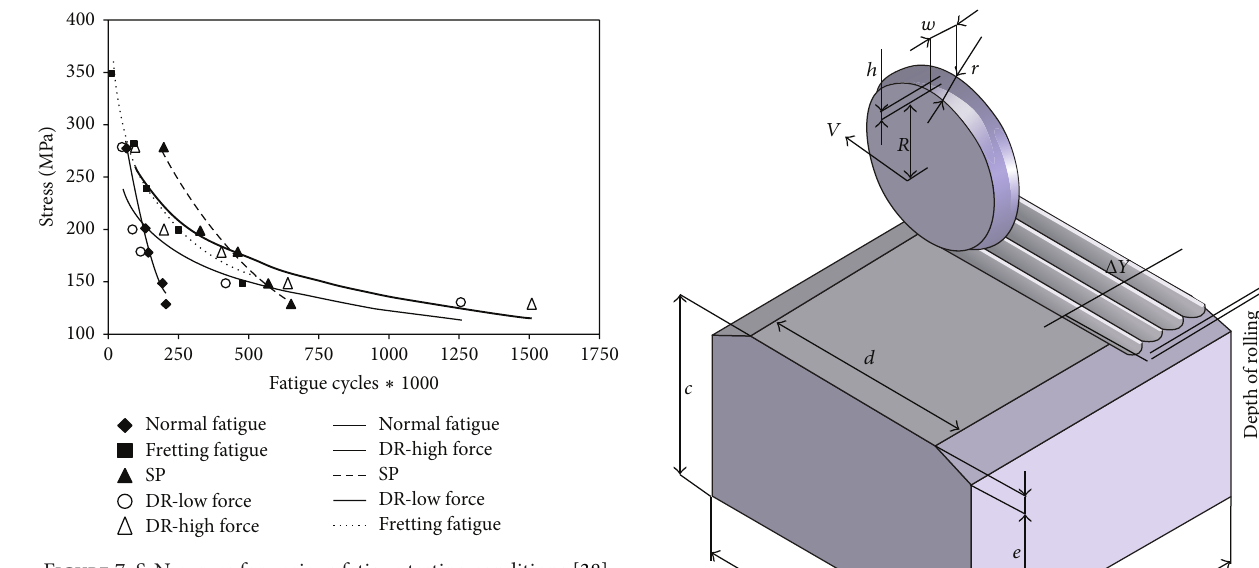
Figure 7: S-N curves for various fatigue testing conditions [38].